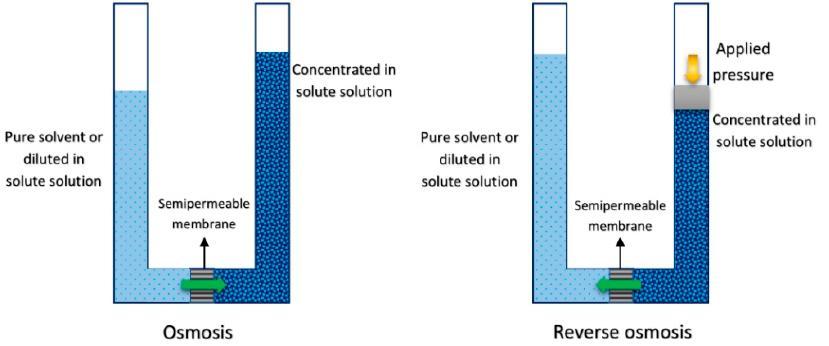
Figure 5. Schematic diagram of osmosis ( left ) and RO ( right ) processes.